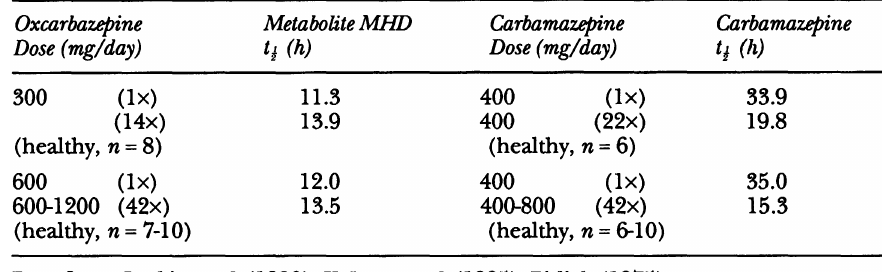
TABLE 1. Half-lives of active substances in man Jollnwing single and multiple doses of oxcarlJazepine and carbamazepine